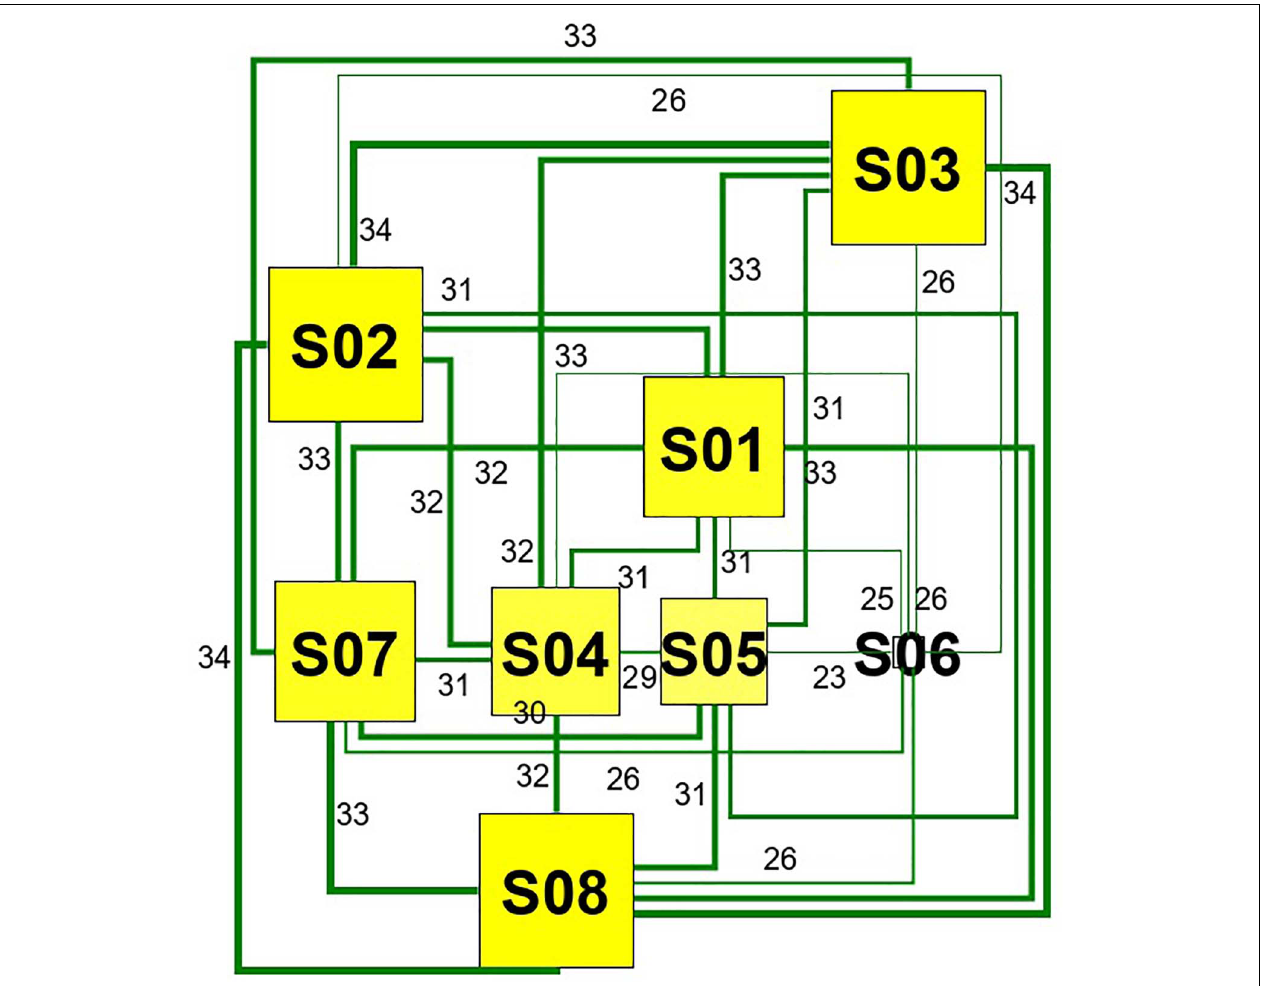
FIGURE 5 | Interlinkages between Solomon Island policies. Each box represents a policy indicated by its label. Policies are linked if they both address the same N themes (N being the weight indicated on the links); links with higher weights are thicker. Box size is related to the sum of the weights of its